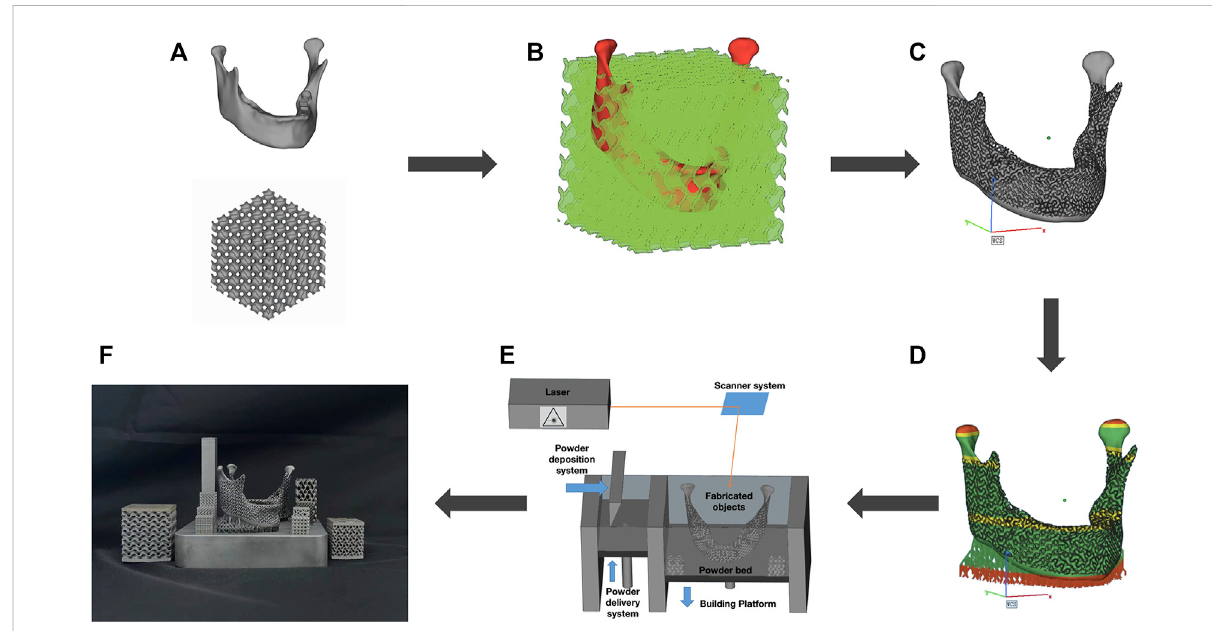
FIGURE 2 TPMSdesignand3D-printing. (A) Reverseengineeringtoextracttargetmodels; (B) Booleanoperations; (C) Personalizeddesign; (D) 3Dprinting risk analysis; (E) SLM fabrication process; (F) Print